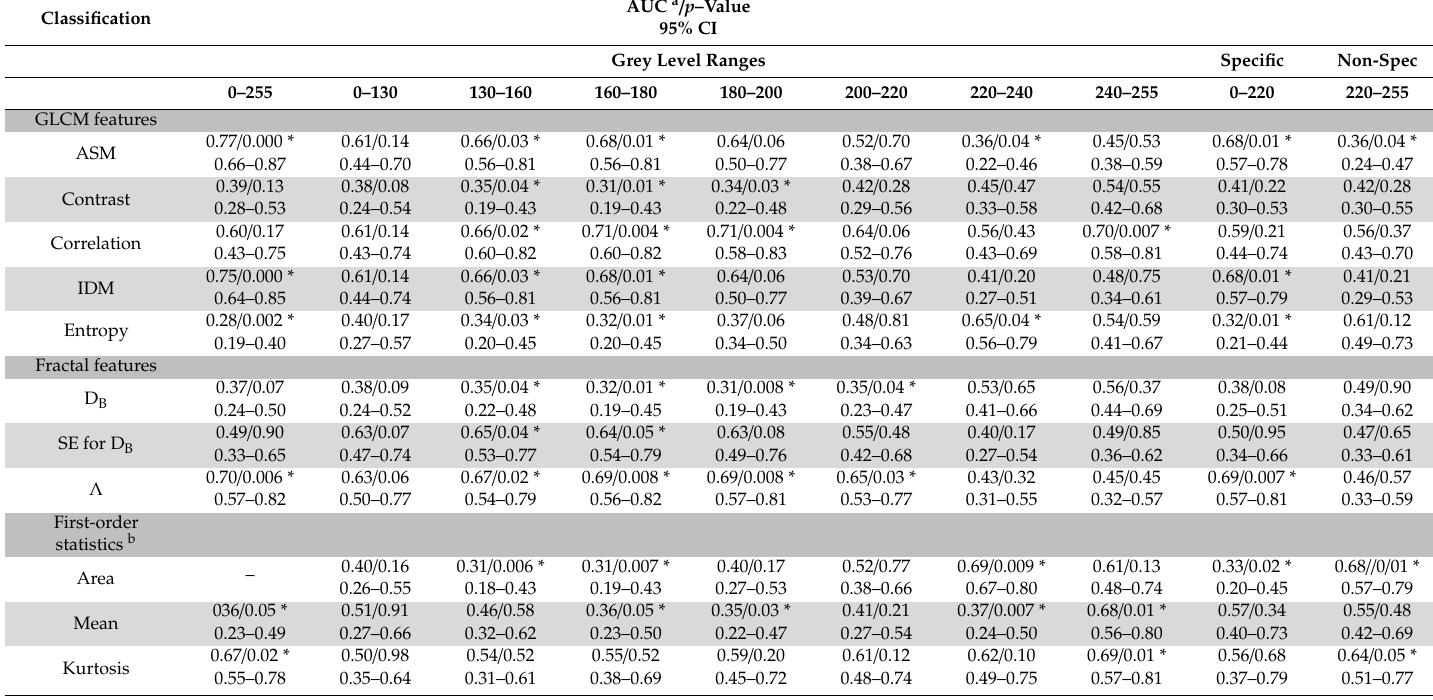
Table 1. Prognostic evaluation of the pan cytokeratin immunostaining